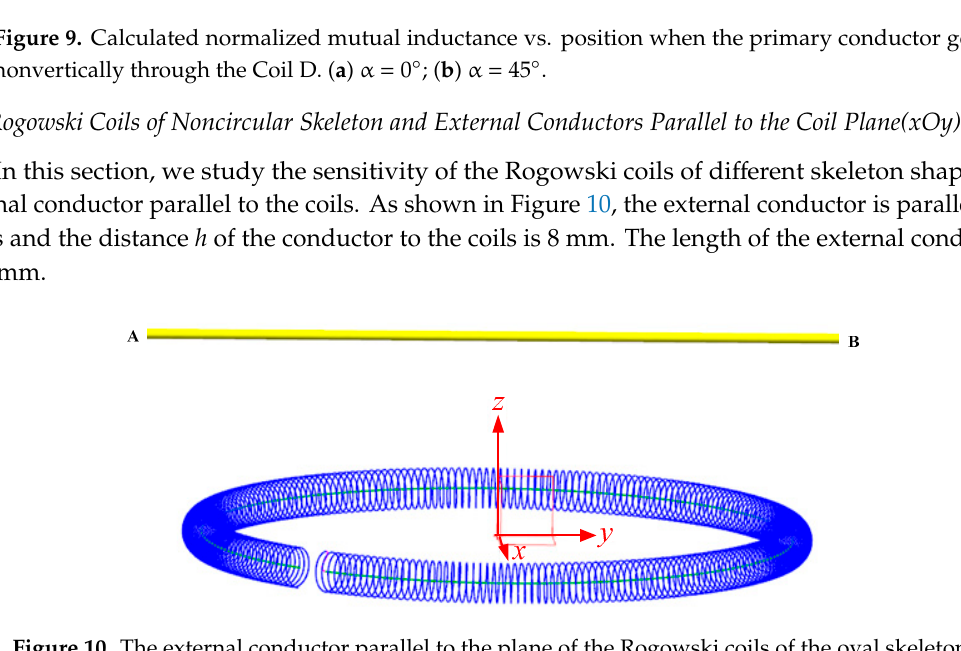
Figure 10. The external conductor parallel to the plane of the Rogowski coils of the oval skeleton.